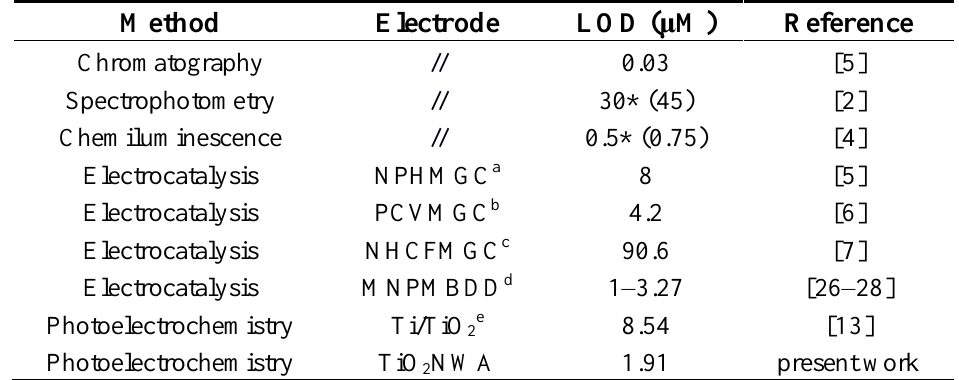
Table 1. Comparison of some of the analytical parameters of the different methods for hydrazine